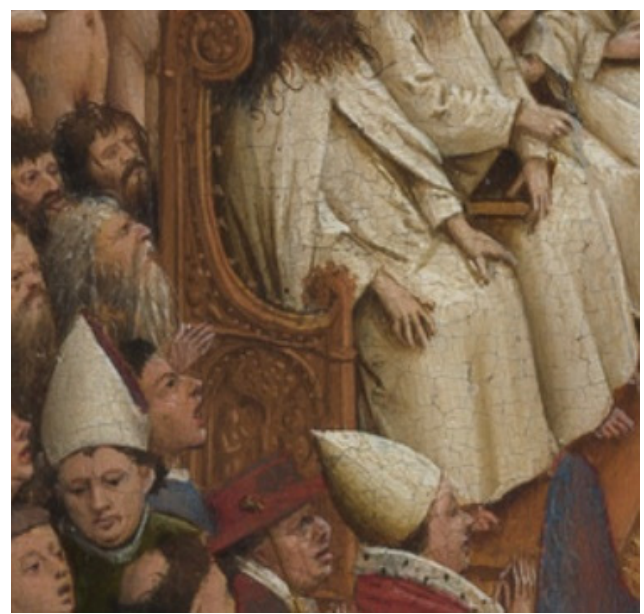
Figure 5. Detail of Figure 1.